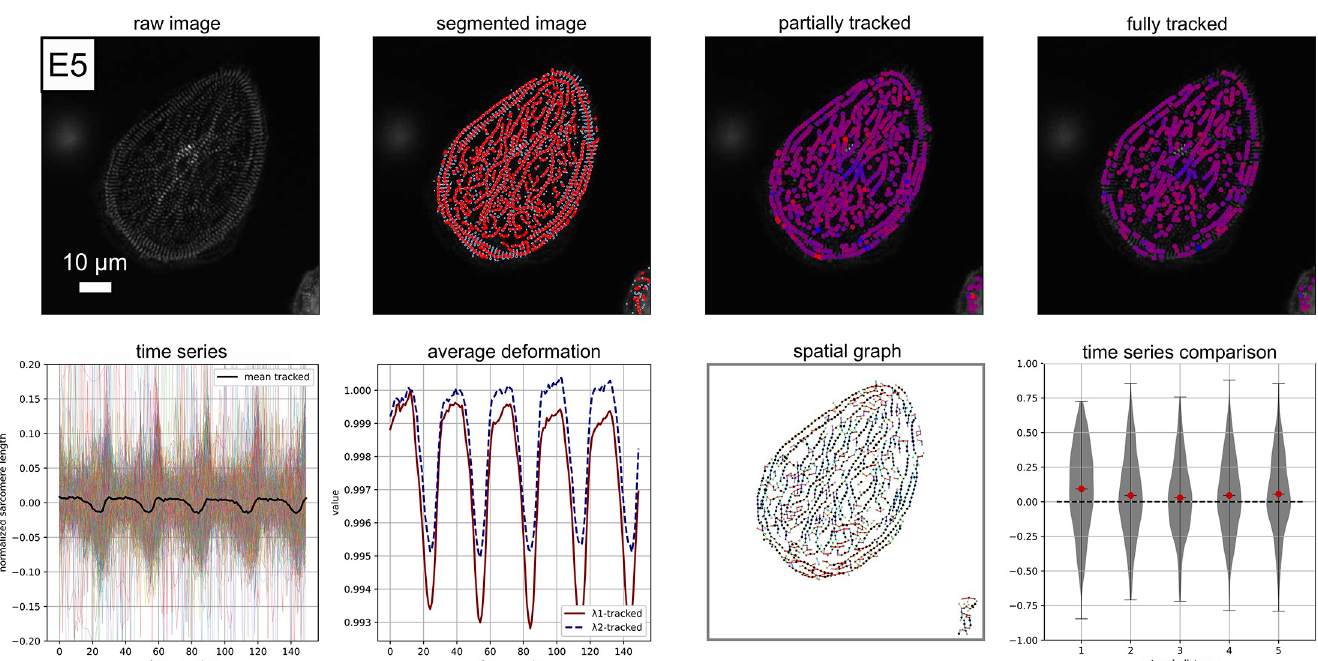
Fig 9. Example performance on experimental data E5: Raw image visualization; z-disc and sarcomere segmentation; Sarcomeres that are tracked for 1/3 or more of the movie, red corresponds to a contracted state, blue corresponds to a relaxed state (frame 50); Sarcomeres that are tracked for 3/4 or more of the movie, red corresponds to a contracted state, blue corresponds to a relaxed state (frame 50), note that these sarcomeres are included in the time series analysis; Individual time series data for normalized sarcomere length; Average deformation behavior; Illustration of the data represented as a spatial graph, color corresponds to sarcomere orientation; Normalized sarcomere time series cross-correlation score plotted as a function of the distance along the network. S5 Movie is included for further visualization.